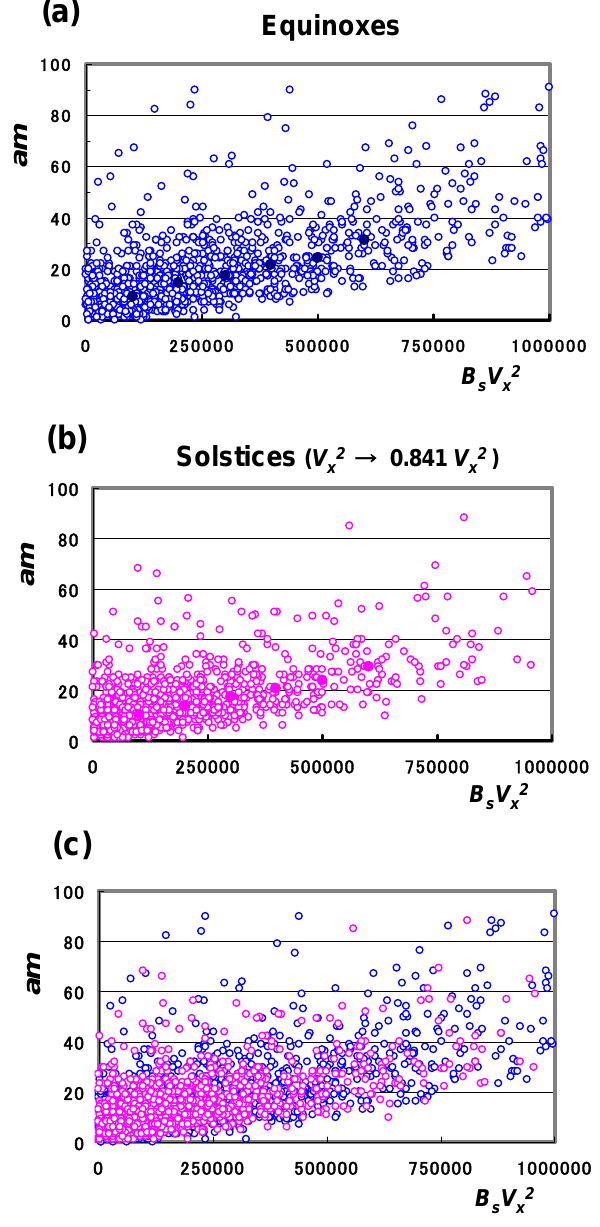
Fig. 2. am index versus B s V 2 x at equinoxes (a) , and at solstices (b) , for 100000 <V 2 x < 200000, where V x is reduced by a factor sin (66.5) for solstices. Average values for several B s V 2 x bins are shown by large blue and red circles, respectively. (c) Superposition of the am-B s V 2 x diagrams for equinoxes (blue) and solstices (red).